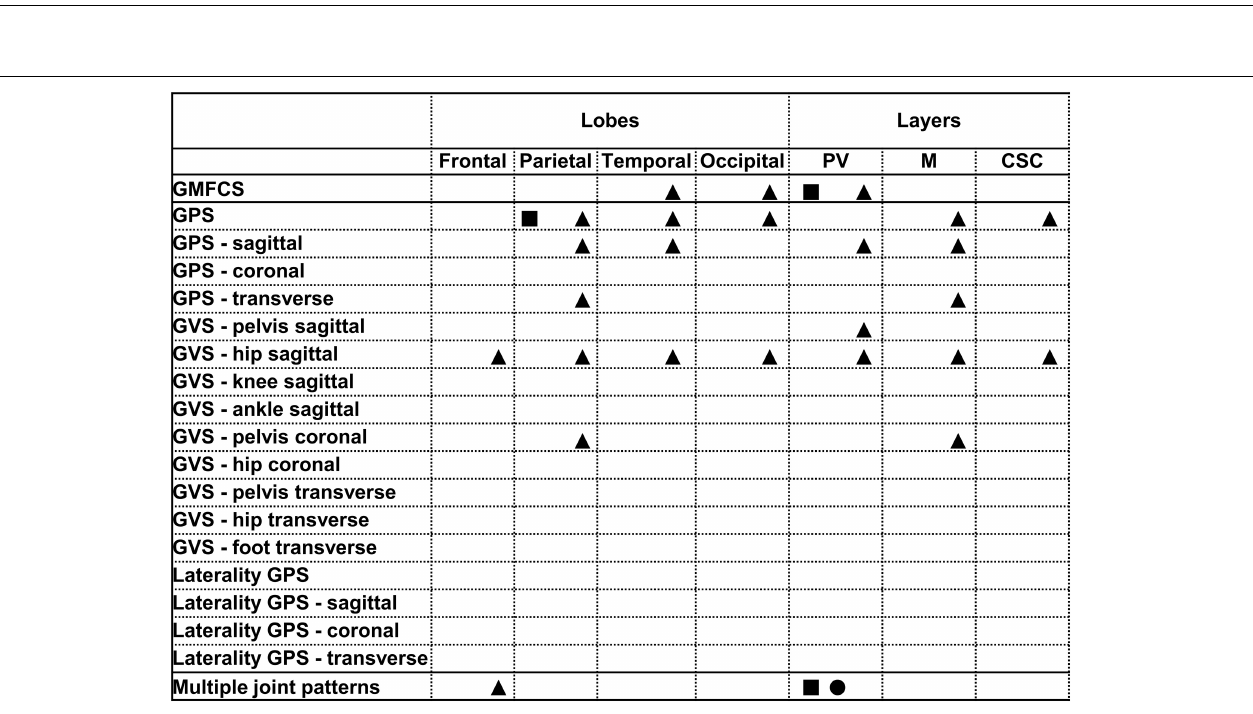
FIGURE 2 | Summary of all statistically significant relationships identified between the lobar and layers brain lesion location scores and the functional and gait scores (i.e., GMFCS, GPSs, GVSs, and MJ patterns). The total group is depicted with a square, the bCP with a circle and the uCP with a triangle (from left to right: total, bCP, uCP). GMFCS, gross motor function classification system; GPS, gait profile score; GVS, gait variable score; MJ, multiple joint; bCP, bilateral cerebral palsy; uCP, unilateral cerebral palsy.